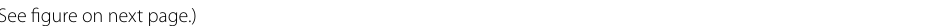
figure on next Fig. 6 Mechanisms of RIPK2 promoting immunotherapy resistance. A The relationship between RIPK2 and CTL dysfunction. B The correlation of RIPK2 and known immune checkpoints marker through all TCGA cancers (*p < 0.05, **p < 0.01, and ***p < 0.001). C GSEA analysis for SKCM and KIRC samples with high RIPK2 expression and low expression. D The correlation of RIPK2 and IFNG, STAT1, IFNAR1 in SKCM and KIRC. E The correlation of RIPK2 and the key components of IL-6/JAK/STAT3 signaling. F Change of RIPK2 expression after pathogen